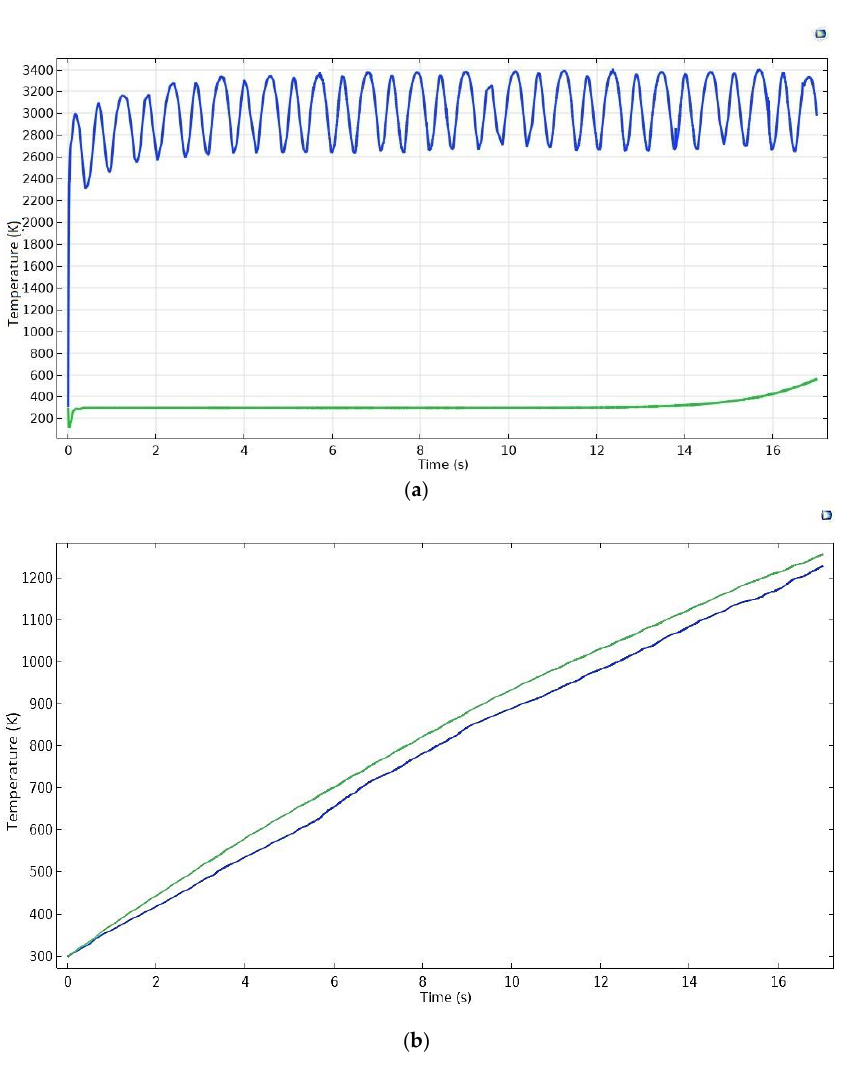
Figure 7. ( a ) Maximum and minimum temperature computational plot for domain 1 (AISI 316L side) and ( b ) comparative average temperature with time for domain 1 (green) and domain 2 (blue).